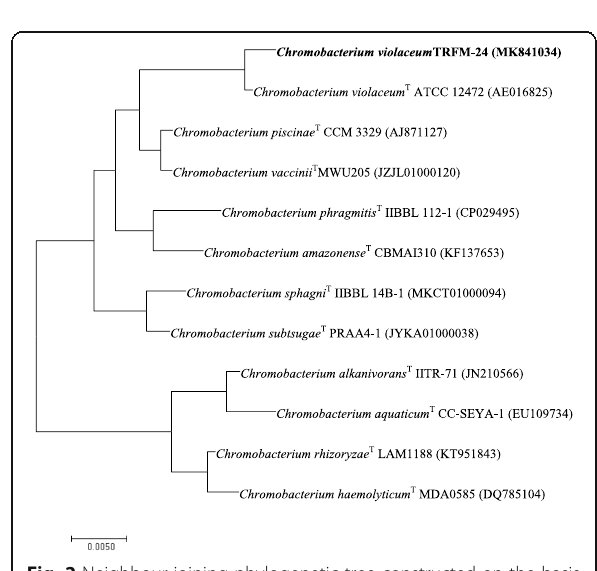
Fig. 2 Neighbour-joining phylogenetic tree constructed on the basis of 16S rRNA gene sequences of C. violaceum strain TRFM-24 and other species of Chromobacterium . The evolutionary tree was constructed using MEGA